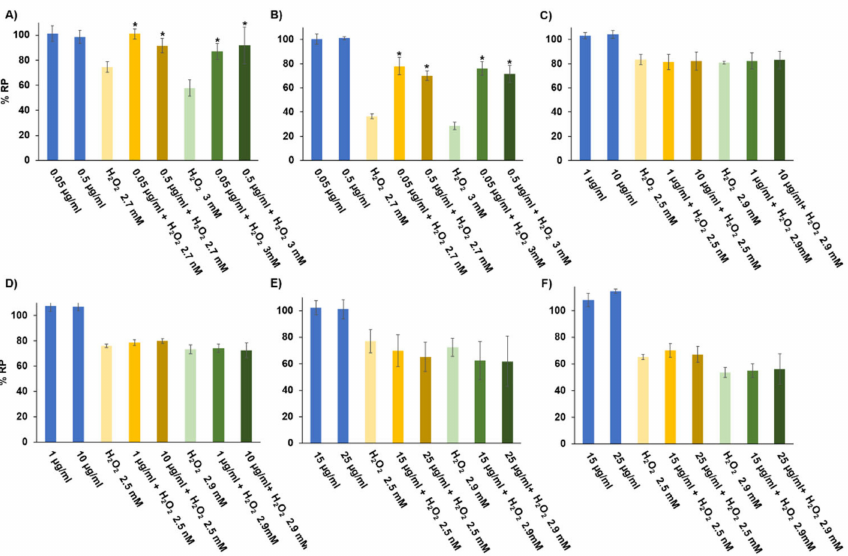
Figure 4. Antioxidant activity of Anemonia sulcata in cultured cells. The HT29 human CRC cell line was exposed to H 2 O 2 and non-toxic doses of: crude homogenates with symbiont (W) ( A ); crude homogenates without symbiont W/O ( B ); ethanolic extract W ( C ); ethanolic extract W/O ( D ); protein hydrolysate W ( E ); and protein hydrolysate W/O ( F ). Relative proliferation was obtained by the MTT protocol. Data are represented as the mean ± standard deviation of octuplicate cultures. The symbol * indicates significant differences with H 2 O 2